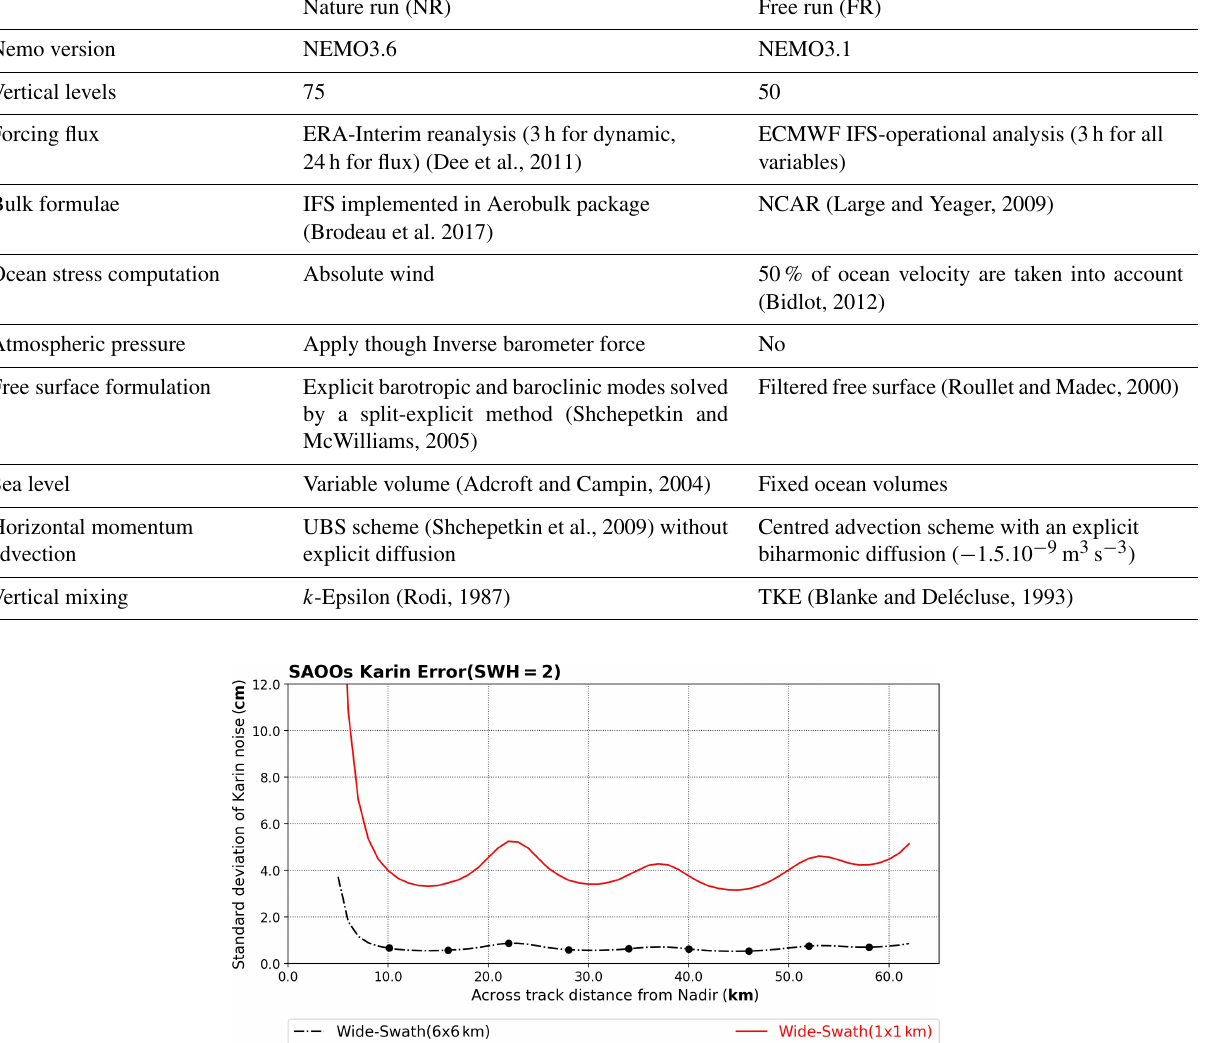
Figure 1. The curves displayed show the wide-swath instrumental error with SWH = 2m (wave height), considering across-swath horizontal resolution of 1km (solid red line) and 6km (dashed black